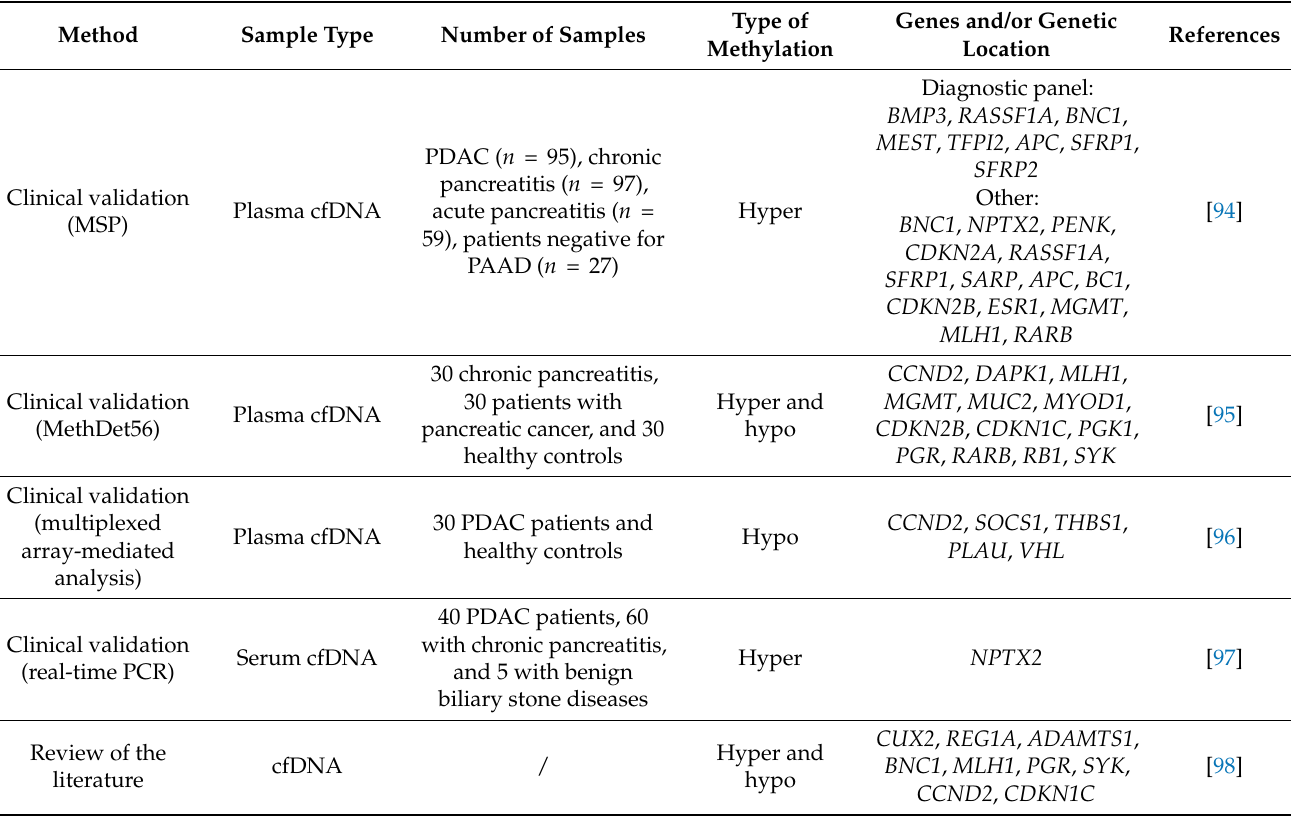
Table 4. An overview of methylation biomarkers for PDAC in liquid biopsy. PDAC: pancreatic ductal adenocarcinoma; cfDNA: cell-free DNA; MSP: methylation-specific polymerase chain reaction; MethDet56: microarray-mediated methylation analysis of 56 fragments in each